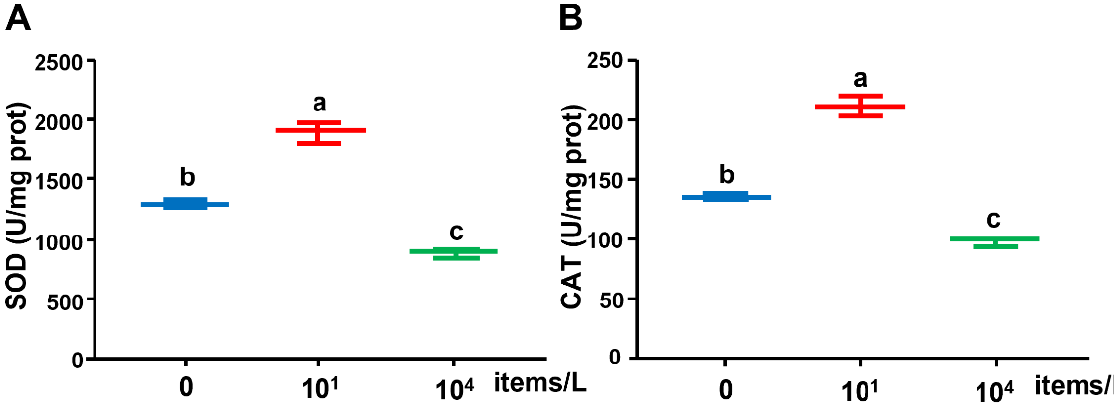
Figure 3. ( A ) SOD and ( B ) CAT activities in the liver of medaka exposed to NPs (0, 10, 10 4 items/L)